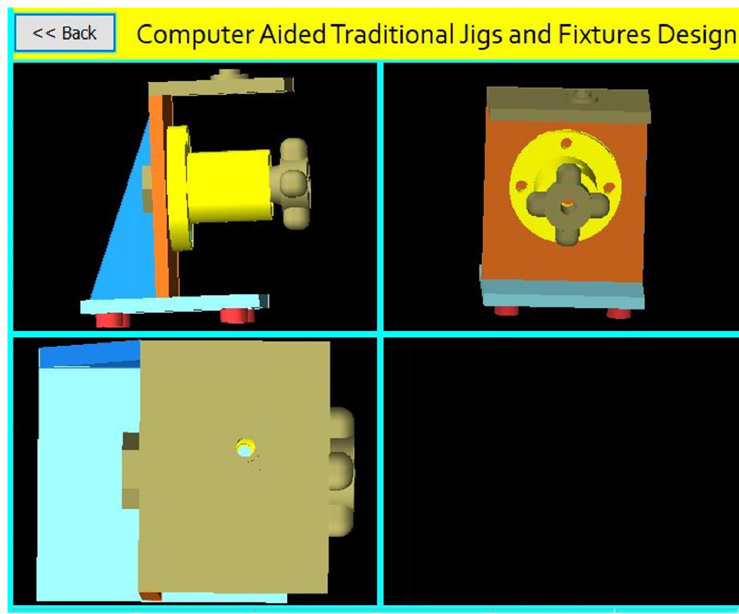
Figure 48. The jig views.